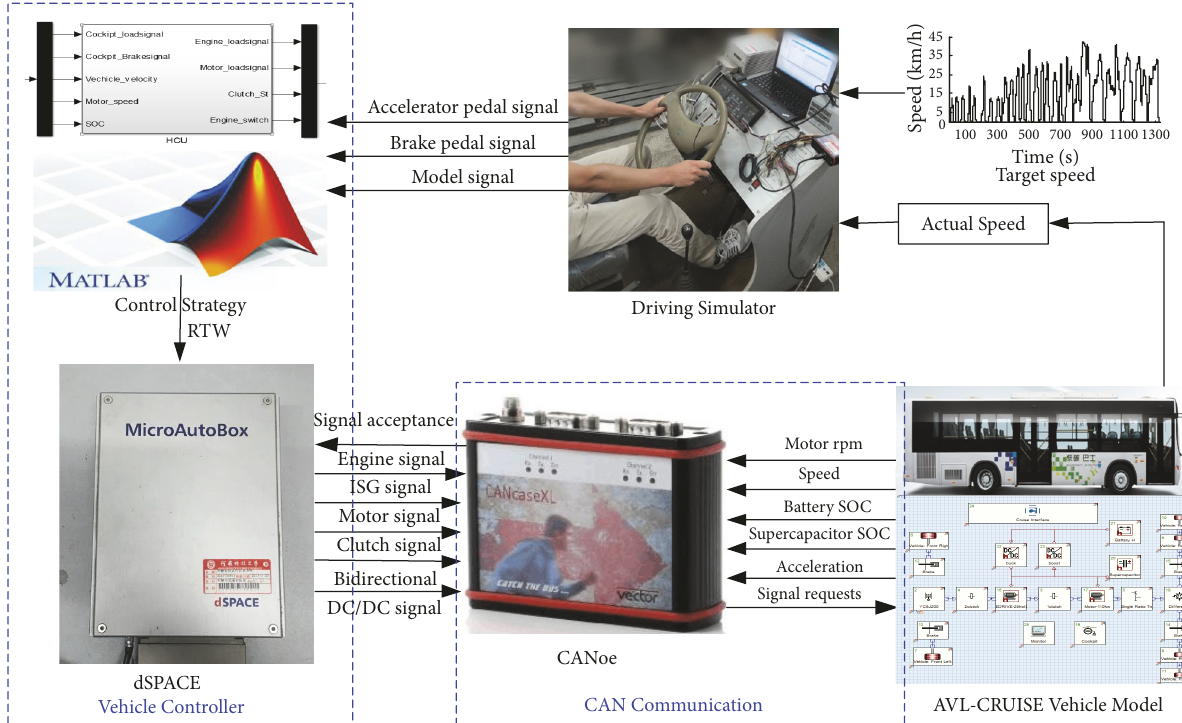
Figure 13: HIL simulation test